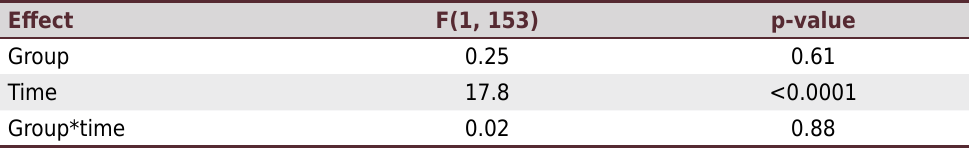
Table 6. Two-way analysis of variance (ANOVA) for attitude toward soil. Confidential code was not considered in this analysis